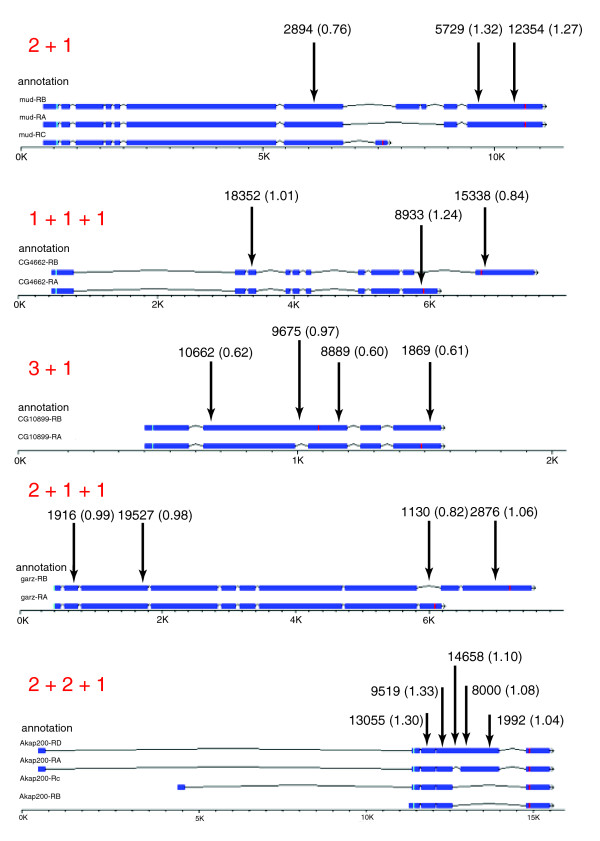
Experimental approach used to detect sex-specific splicing. Probes designed based on sequence clustering may target either constitutive or alternatively transcribed exons. Each panel shows a different example of probe distribution among constitutive and alternatively transcribed regions. For instance, '2+1+1' indicates that the corresponding gene has two probes targeting a common region and one probe targeting each of two alternatively transcribed regions, '3+1' indicates that the gene has three common probes and one probe that targets an alternatively transcribed region, and so on. For each probe, the figure shows its designating number, location in the transcript, and the ratio of the normalized and log-transformed (natural log) values between females (numerator) and males (denominator). Note that different probes that target the same subset of transcripts have similar values for the normalized log transformed male/female expression ratios, even if they are located in different exons. In contrast, probes that target alternatively spliced regions have different values for the normalized log transformed male/female expression ratios.